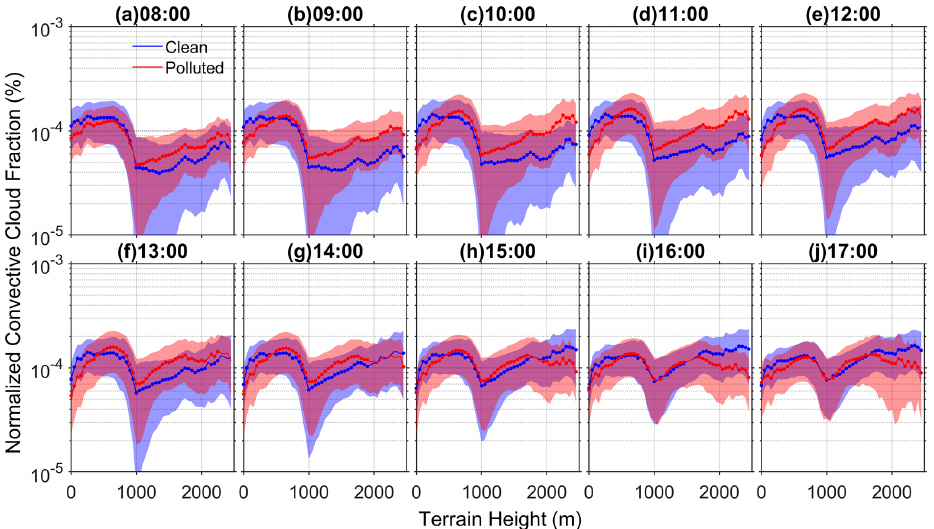
Figure 10. Same as Fig. 9, but for CCF C(P) which is normalized by the number of cases under polluted and clean conditions during each hour, i.e., NCCF C(P) , respectively (Eq.